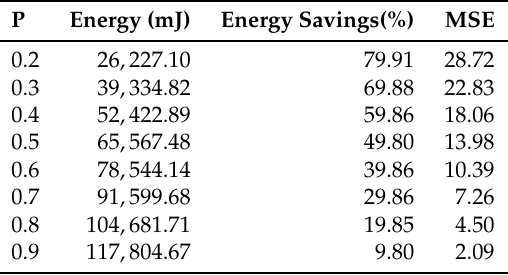
Table 5. LEACH protocol